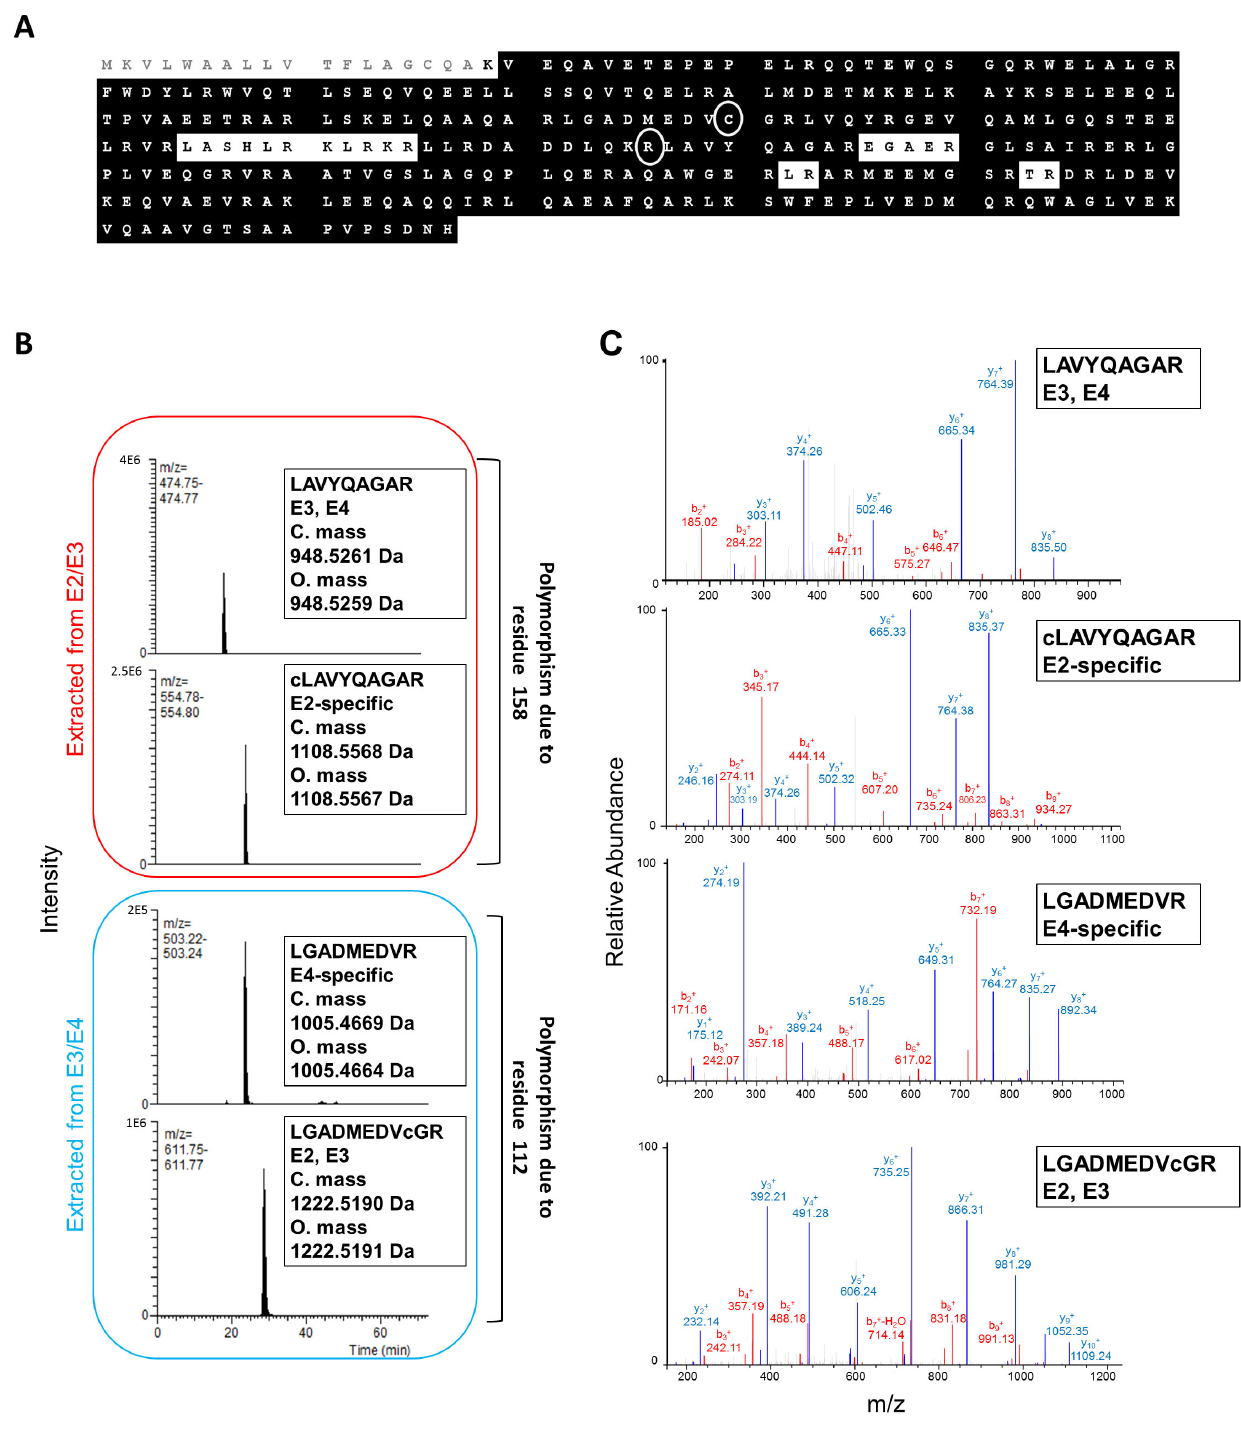
Figure 1. Apolipoprotein E resequencing and its application to serotyping. ( A ) ApoE resequencing. Figure shows a representative result of wild-type ApoE amino acid sequence determination (sequence coverage=93.6%, excluding the 18-residue signal peptide) using Orbitrap LC-MS/MS. Black highlighting denotes the determined sequence. Amino acid residues C112 and R158, which demonstrate polymorphism in ApoE2 (C158) and ApoE4 (R112), are circled. Amino acids are represented by their one-letter codes. ( B ) Tryptic peptide polymorphisms and ion chromatograms. Mutations in amino acid residues 112 and 158, which were covered by protein resequencing, cause peptide fragment polymorphisms. The R158C mutation (ApoE2) results in the cLAVYQAGAR peptide, where the C112R mutation (ApoE4) yields the LGADMEDVR peptide. Figure shows representative chromatograms for the doubly charged ions extracted from subjects with E2/E3 and E3/E4 heterozygous combinations. The calculated and observed monoisotopic masses for each peptide are indicated. ( C ) Corresponding MS/MS spectra for each peptide in ( B ). Polymorphic peptide sequences from subjects with heterozygous combinations were confirmed by MS/MS. The b- and y-ions are labeled. In ( B ) and ( C ), lower-case ‘‘c’’ represents alkylated cysteine residues. C. mass=calculated mass; O. mass=observed mass; Da=dalton.